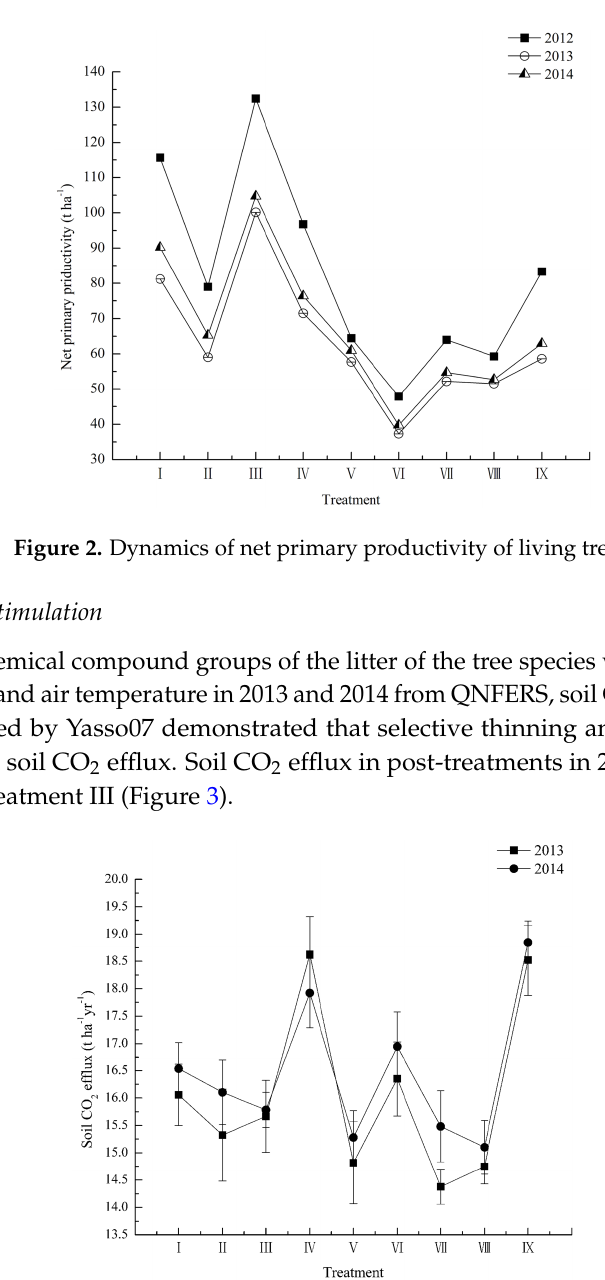
Figure 3. Soil CO 2 efflux in post ‐ treatments.